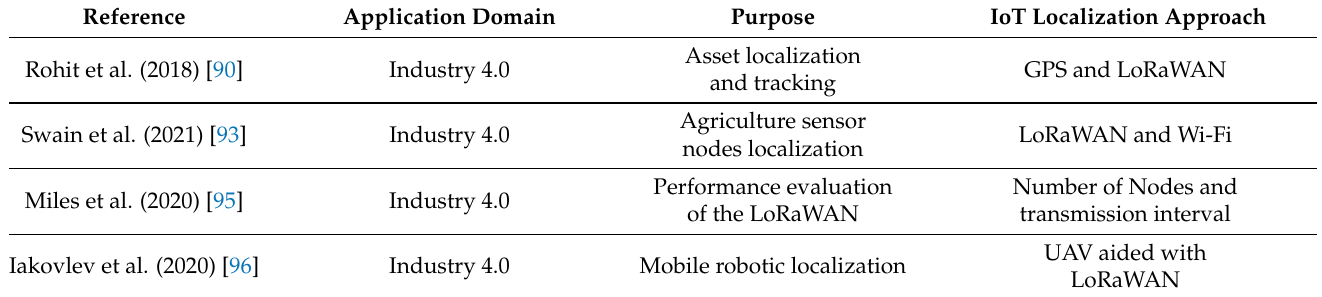
Table 4. Summary of different proposed method for IoT systems